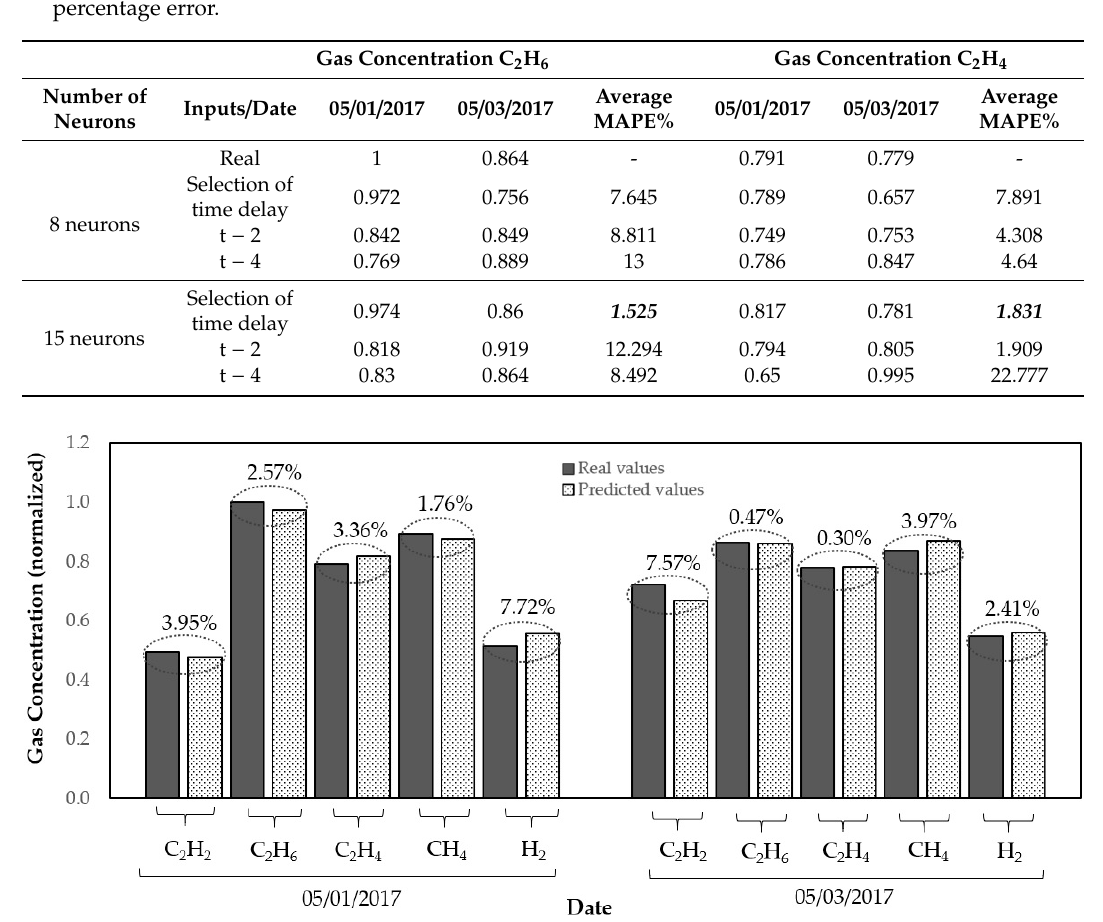
Figure 3. Real and predicted values of the gas concentration for two Table 1. Fault description for gas concentration.